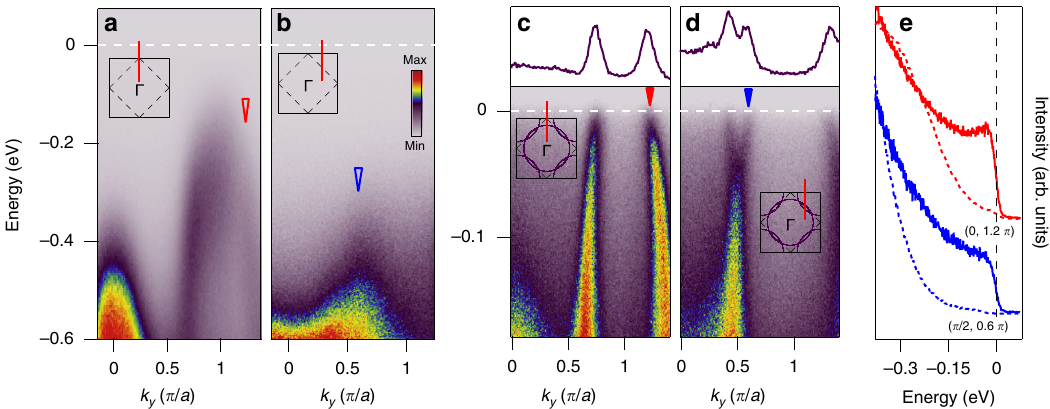
Fig. 3 Dispersions measured with h ν = 21.2 eV. a ARPES spectra along (0,0) − (0, π ) and b along ( π /2,0) − ( π /2, π ) in undoped Sr 2 IrO 4 ; insets show the Brillouin zone with red lines indicating the direction of the dispersion. Blue and red arrows show the momentum of the EDCs shown in e . c , d Corresponding ARPES spectra for Sr 1.93 K 0.07 IrO 4 intersecting the square hole pocket c and elliptical electron pocket d with MDCs at E F shown at the top. e EDCs at k F in the doped samples (solid lines) and corresponding EDCs at the same k in the undoped samples (dashed lines), indicating a clear shift of spectral weight towards the Fermi level and a quasiparticle peak at (0,1.2 π /a).